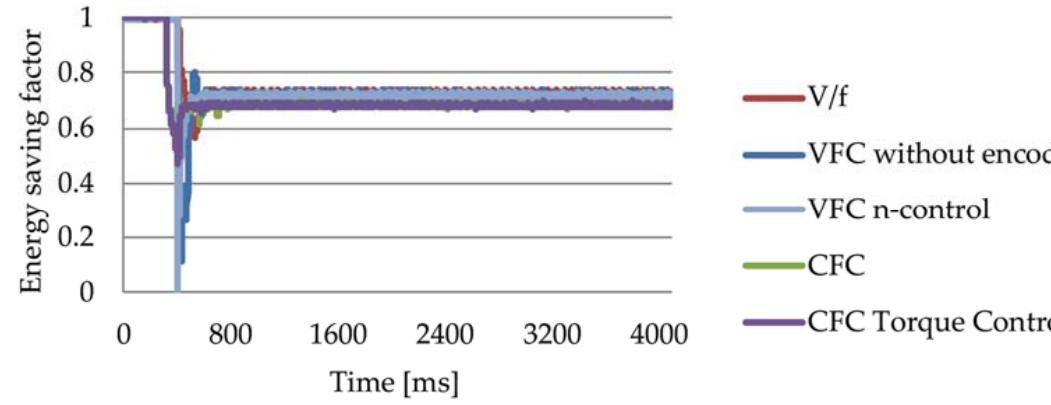
Figure 6. Comparison of the energy saving factor (E SF ) for various control modes (without an external load). Based on the calculated S C and E SF , the E F was determined and averaged over two drive states: the transient state and steady state in the unloaded condition. The results are presented in Table